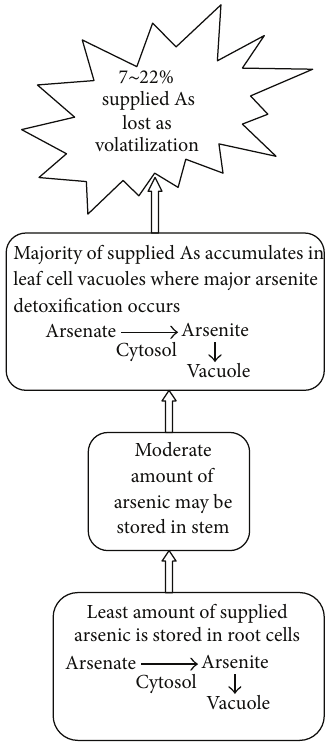
Figure 1: The overview of arsenic accumulation during phytoreme- diation experiments as suggested by the recent studies of Mirza et al. [91] and Doucleff and Terry [92]. It was suggested that arsenic is absorbed as arsenate and some part of it is converted into arsenite by an enzyme called arsenate reductase. Arsenite is stored in vacuole and is further detoxified. Majority of arsenate is transported to leaf cells where it is again converted into arsenite (in cytosol) and stored/detoxified in vacuoles. Still majority of investigators have proposed that arsenite form is transported from roots to